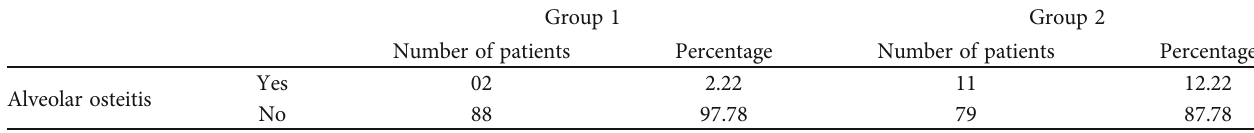
T ABLE 3: Comparison of alveolar osteitis between both groups ( n = 180).